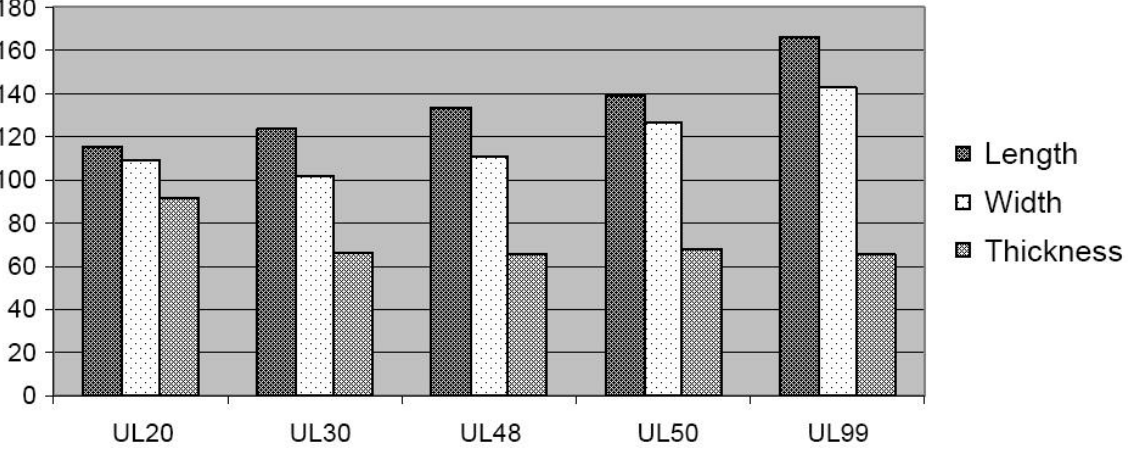
Figure 11. Worked pebbles dimensions (mm) distributed by the lithological units that contained worked